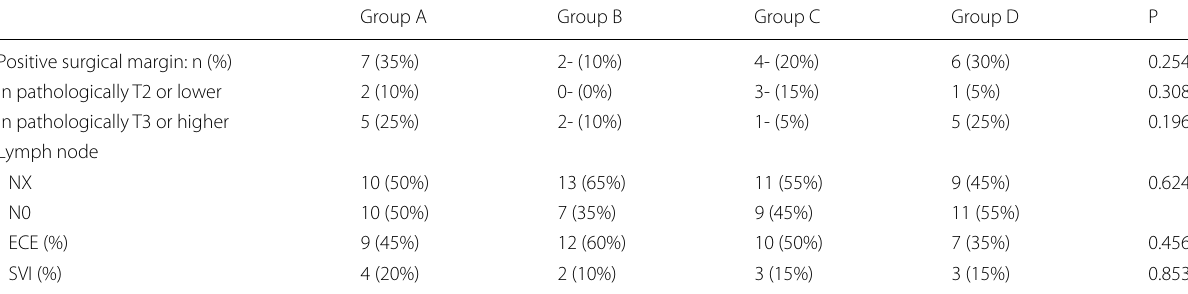
Table 3 Postoperative pathological